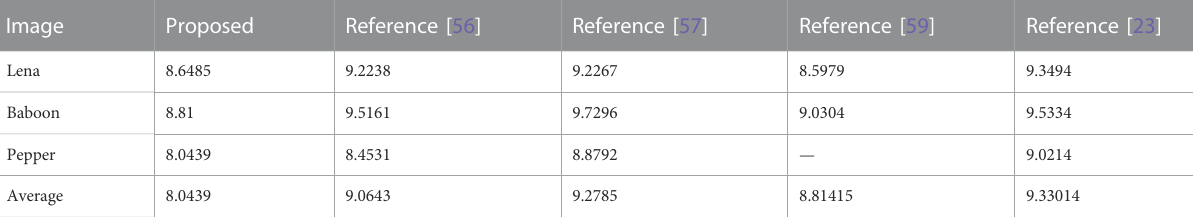
TABLE 4 Result of PSNR analysis.